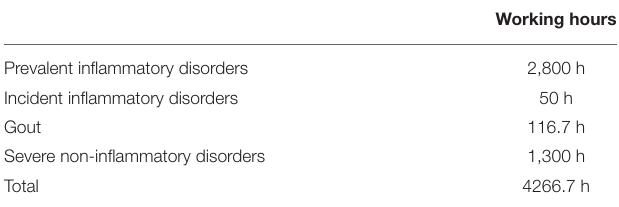
TABLE 4 | Time need per 100,000 adult inhabitants per